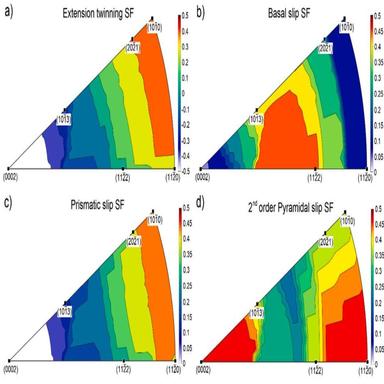
Inverse pole figures representing the SF values calculated for the a) extension twinning, b) basal slip, c) prismatic slip and d) 2nd order pyramidal slip with respect to compressive loading in the out-of-plane direction.